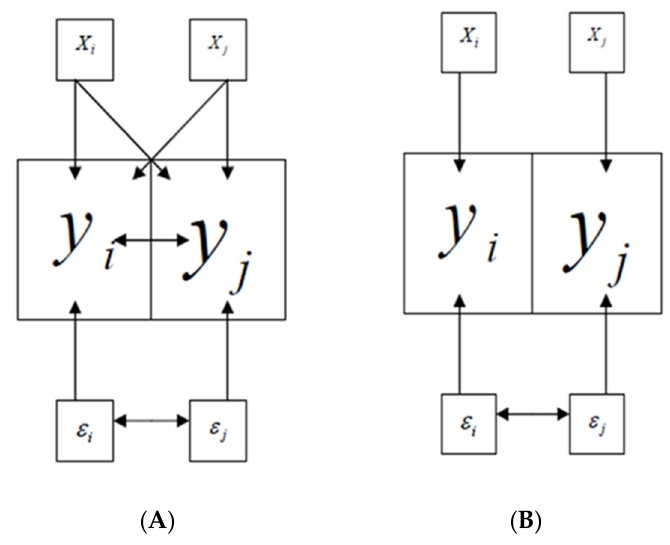
Figure 4. Spatial dependency (( A )—spatial lag dependency; ( B )—spatial error dependency).